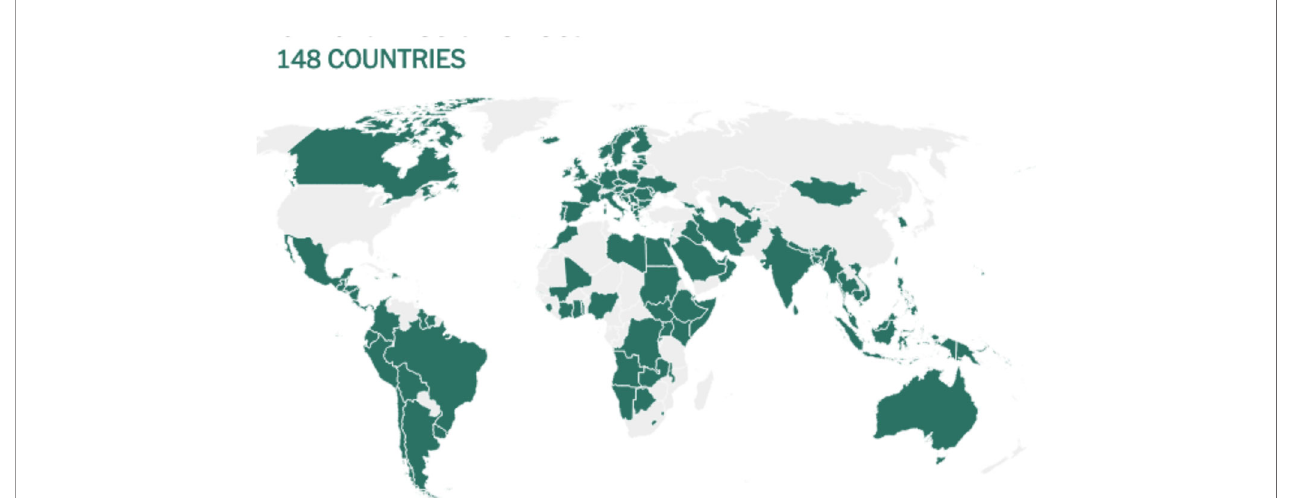
FIGURE 11 | Countries where the Vaxzevria (Oxford-AstraZeneca) vaccine is being used as of May 10, 2021. Source: Our World in Data (https://ourworldindata.org/).